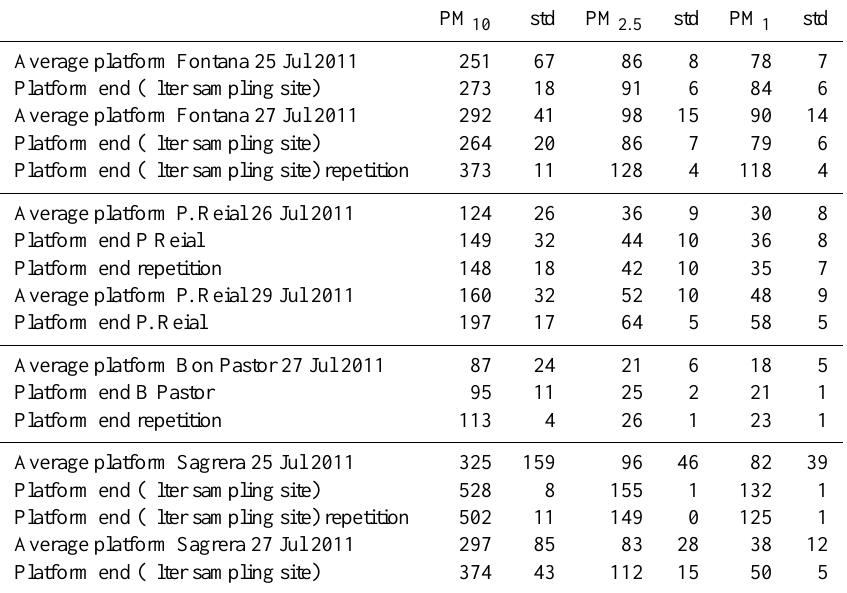
Table 1. PM x levels and standard deviation (std) of 5min values (µgm − 3 ) measured across the platforms at different metro stations from L9 and L3 lines. Mean data of the sampling sites (at the platform end) are also reported for comparison with the mean weighted values measured across the